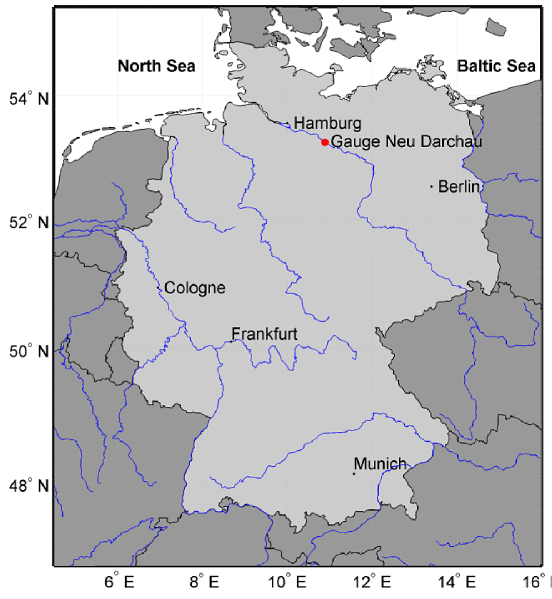
Figure 1. Location of gauge Neu Darchau at the Elbe